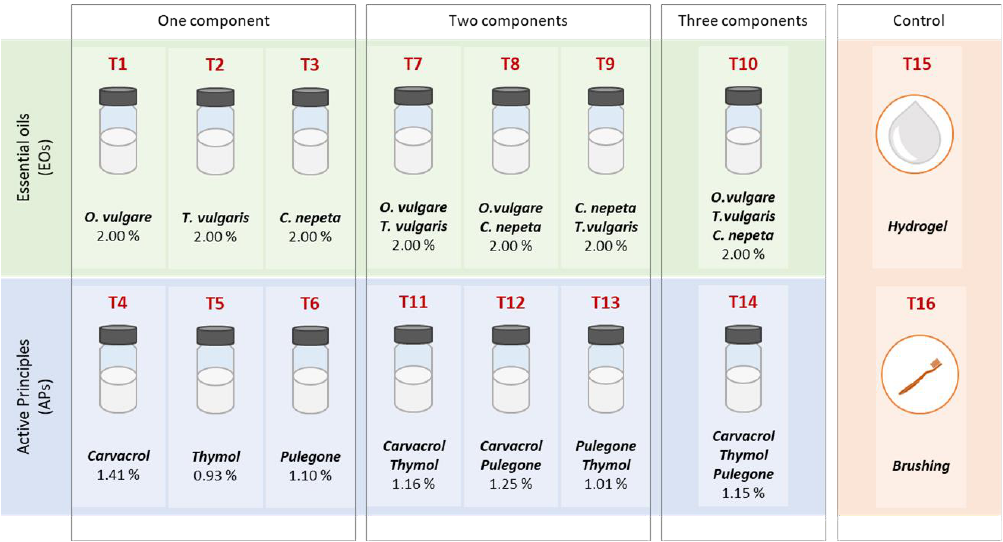
Figure 3. Schematic representation of the treatments employed and their composition.